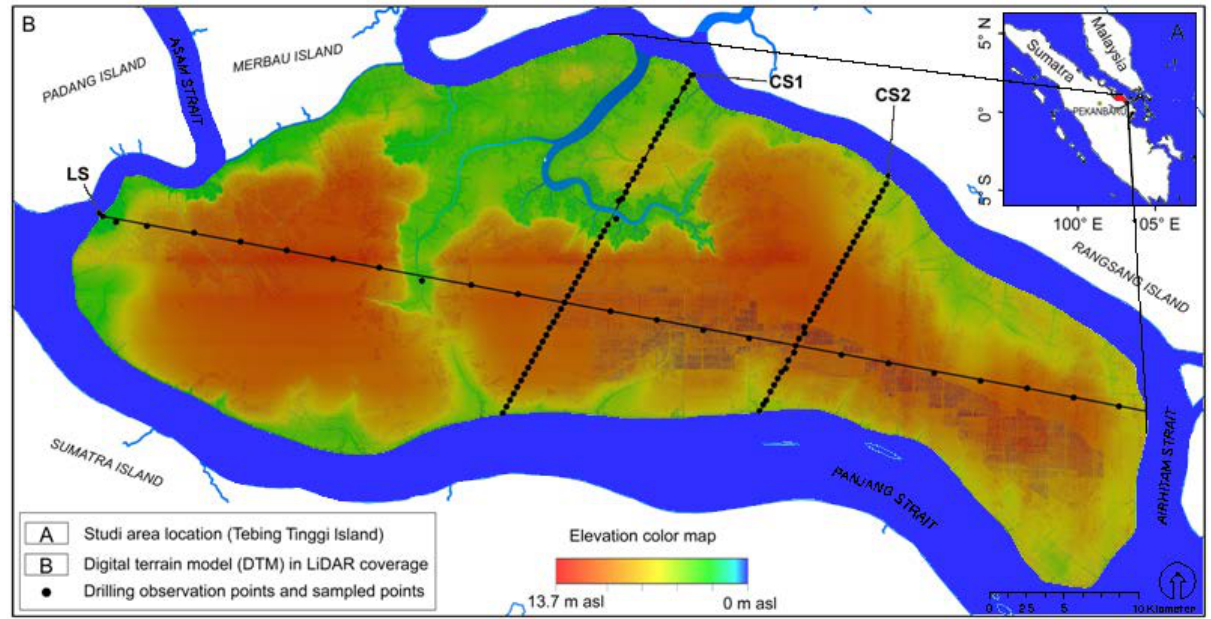
Figure 2. A (inset): the location of Tebing Tinggi Island in relation to Sumatra and peninsular Malaysia. B: the LiDAR coverage of Tebing Tinggi Island, shown as a digital terrain model (DTM; resolution 0.5 m) with our survey lines (LS, CS1, CS2) and plantation blocks of the sago concession (see outline in Figure 3)